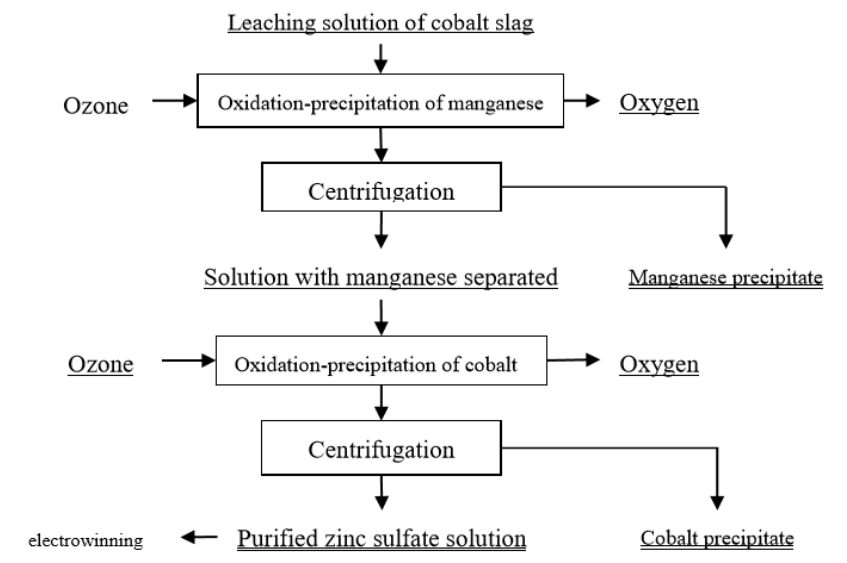
Figure 8 – Flowsheet of the two-stage method for manganese & cobalt recovery by ozone (Tian et al, 2017, pp 201-206) Рис . 8 – Двухступенчатый метод извлечения марганца и кобальта с помощью озона (Tian et al, 2017, pp 201-206) Слика 8 – Двостепени метод за издвајање мангана и кобалта коришћењем озона (Tian et al, 2017, pp